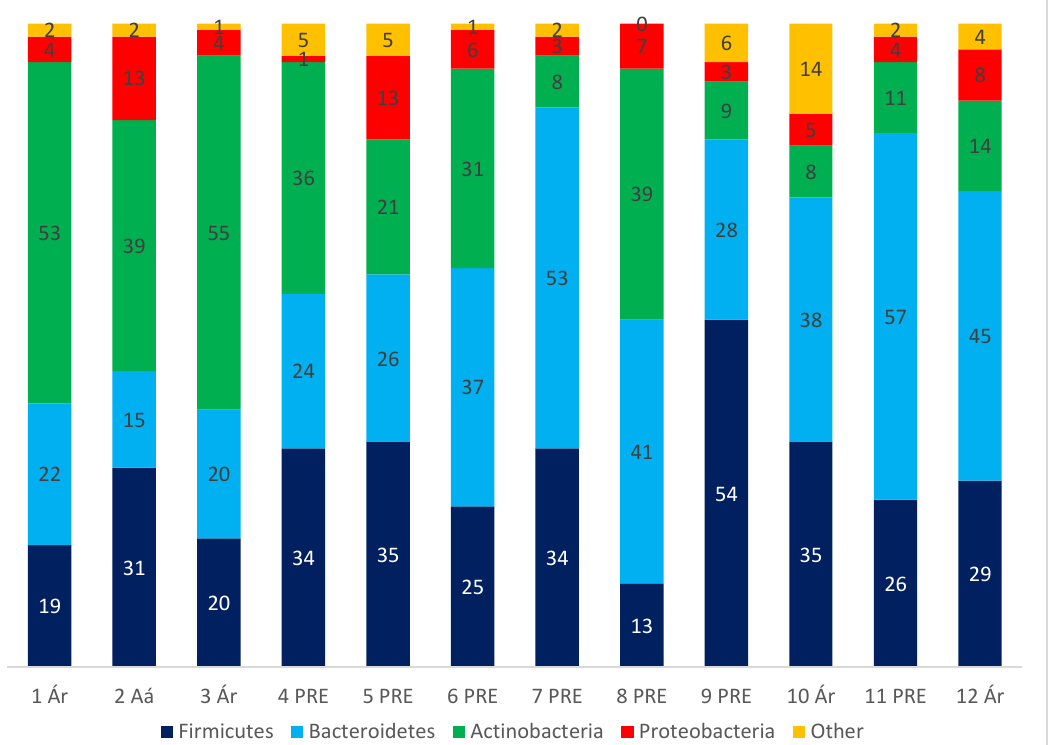
Figure 2. Graphical representation of bacteria the four more abundant phyla in samples. Numbers in X axis represent animals. PRE: Andalusian. Aa: Anglo-Arabian. Ar: Arabian. Numbers inside the bars represent the percentage of abundance of each phyla.